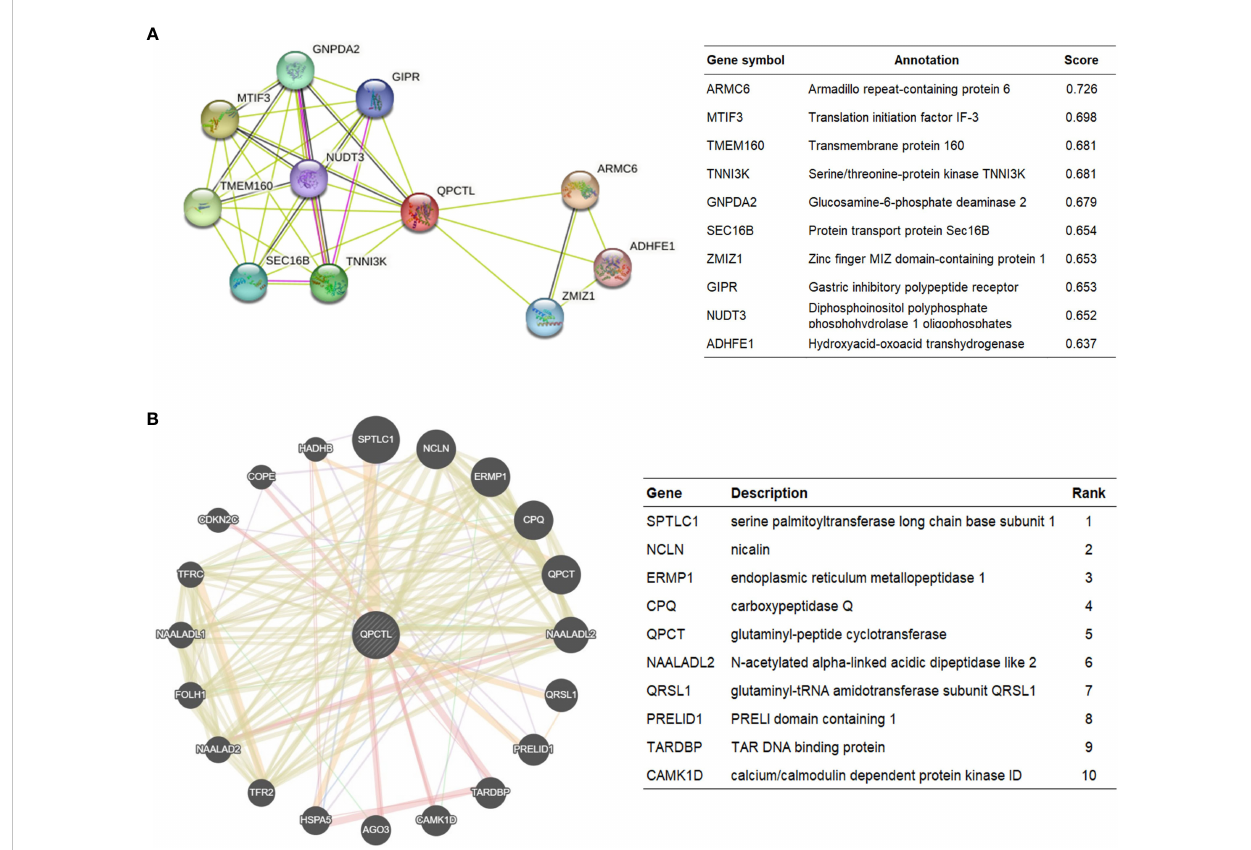
FIGURE 4 QPCTL – interaction proteins. (A) Annotation of QPCTL-interacting proteins and their co-expression scores, data from STRING website (https:// string-db.org/). (B) Annotation of QPCT – interaction proteins and their correlation scores, data from Geneaminia website